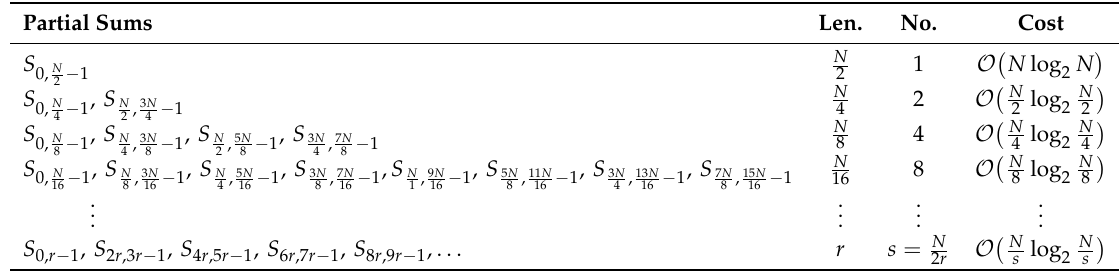
Table 1. Partial sums, their length, number and computational cost for the evaluation of T 0 ( N ) . Partial